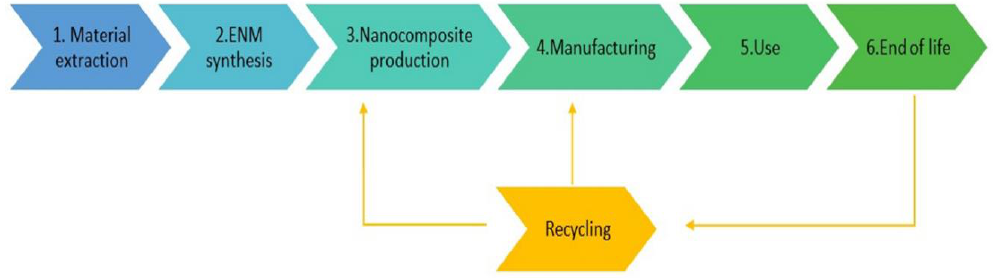
Figure 1. Life-cycle steps of nano-enabled products .